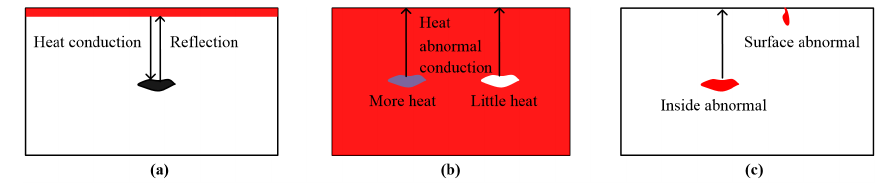
Figure 4. Styles of heating: ( a ) SHT; ( b ) VHT; ( c ) AHT.